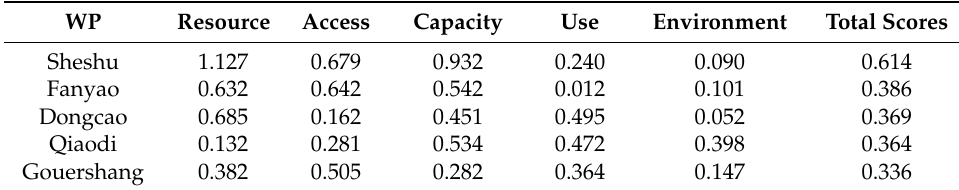
Table 3. Calculated values of WPI and its